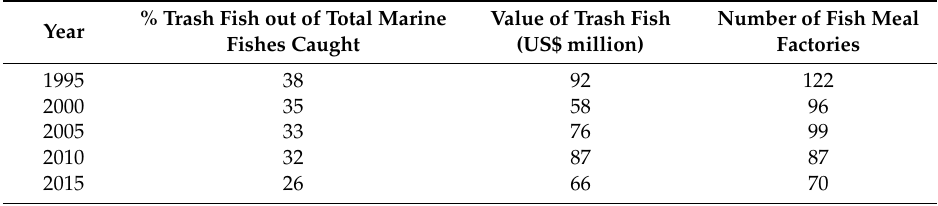
Table 1. The proportion of trash fish to total marine fishes caught in Thai coastal waters, their value, and the number of fish meal factories from 1995 to 2015.